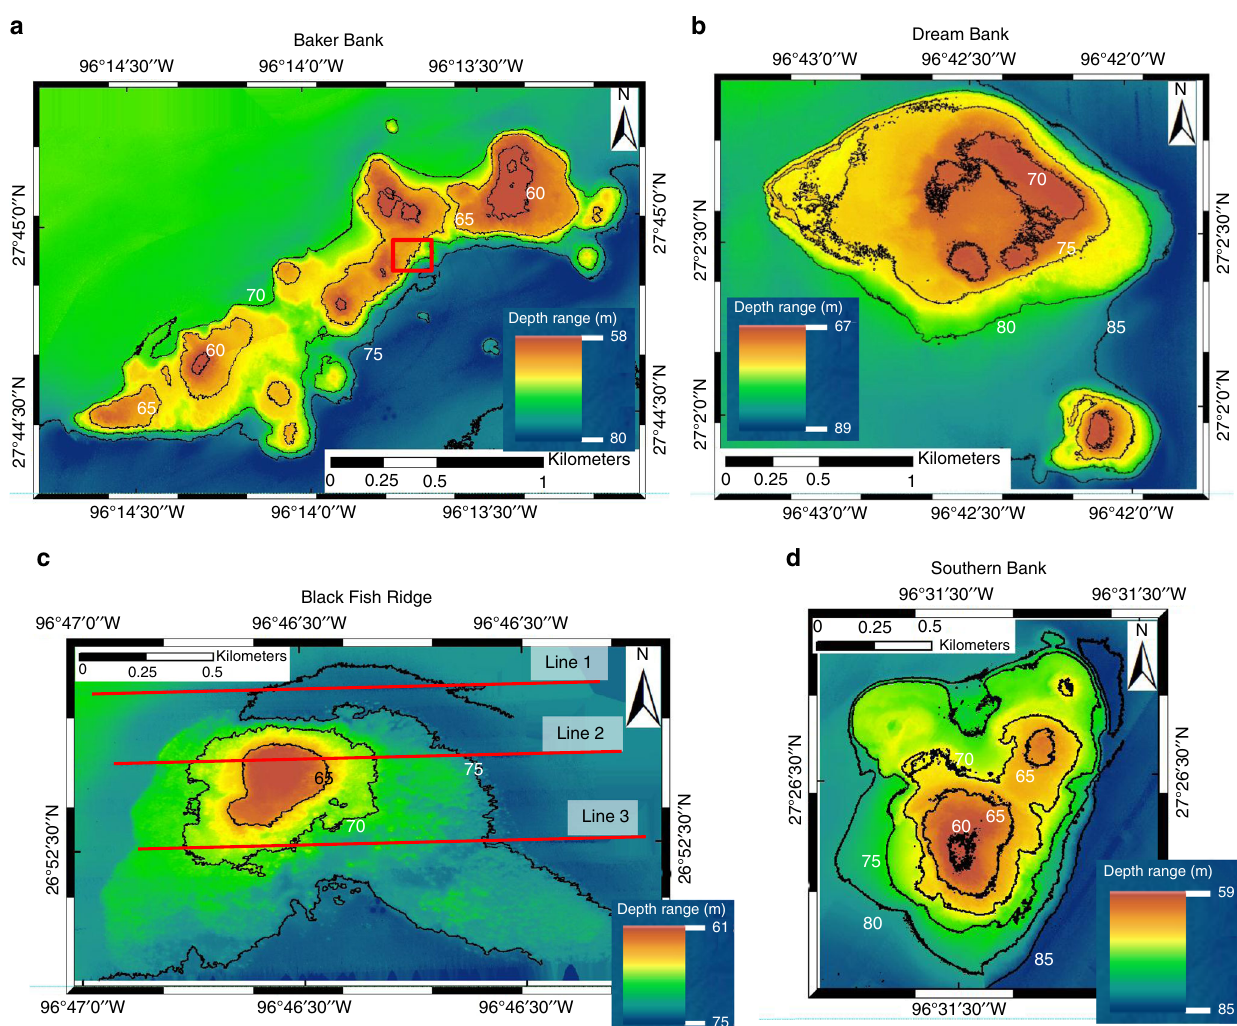
Fig. 2 High-resolution multibeam bathymetric maps illustrate the morphology of four of the ten imaged drowned coralgal reefs. a Baker Bank, b Dream Bank, c Black fi sh Ridge, and d Southern Bank (see Fig. 1a for their geographical locations). Spurs (ridges) and grooves (troughs) are usually identi fi ed on the south-eastern (windward) side of the banks; the red rectangle in Fig. 2a locates well-developed spurs and grooves shown in Fig. 3a. Dream Bank in Fig. 2b represents distinct atoll morphologies, with well-developed lagoons surrounded by rimmed margins (see Fig. 3c). Dream Bank also clearly displays a set of distinct terraces, illustrated in Fig. 3d, e. Red lines on Fig. 2c locate the three 3.5 kHz seismic lines (1, 2, 3) shown in Fig.